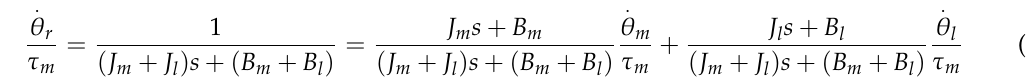
Figure 5. Block diagram of the rigid-body velocity solver: ( a ) the weighted sum of motor velocity and link velocity from dual encoders; ( b ) the Bode plot from τ m to The transfer function from input torque τ m to rigid-body velocity . θ